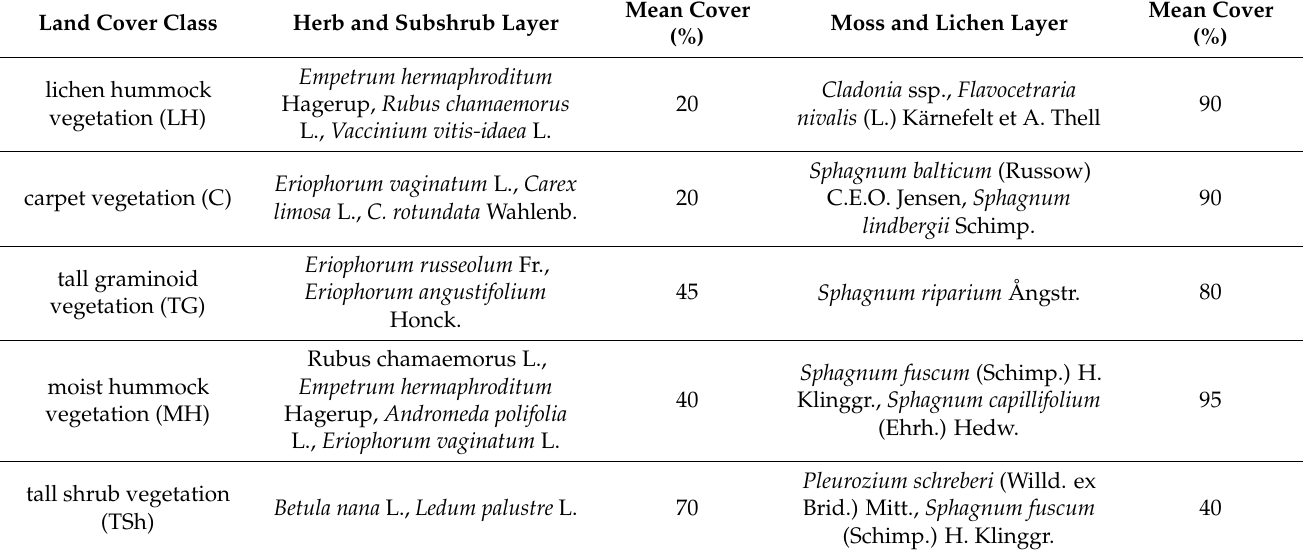
Table 2. Geobotanical characteristics of individual land cover